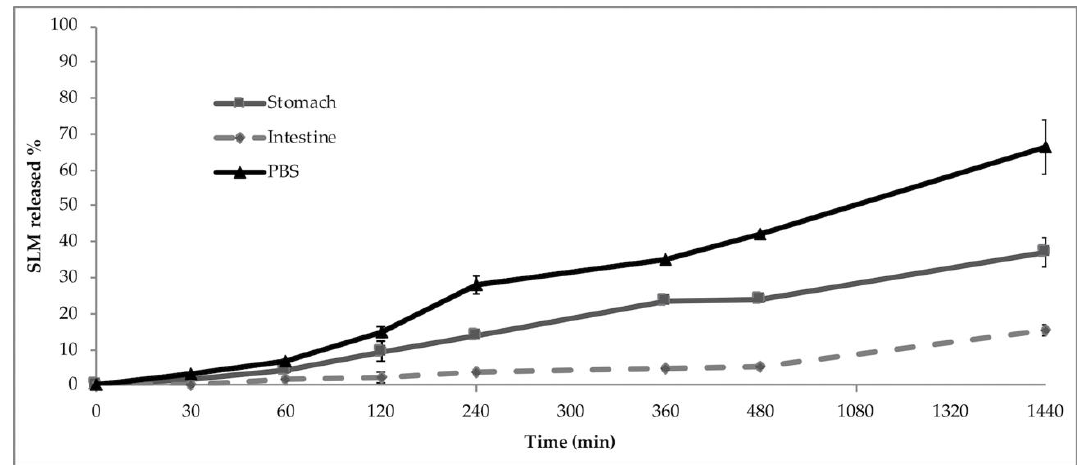
Figure 2. In vitro release studies of SLM-NLCs in phosphate buffered saline (PBS) pH 7.4 (black line) and in simulated gastrointestinal fluids (dark grey line and light grey dotted line). Results are expressed as means ± standard deviation, n = 3.